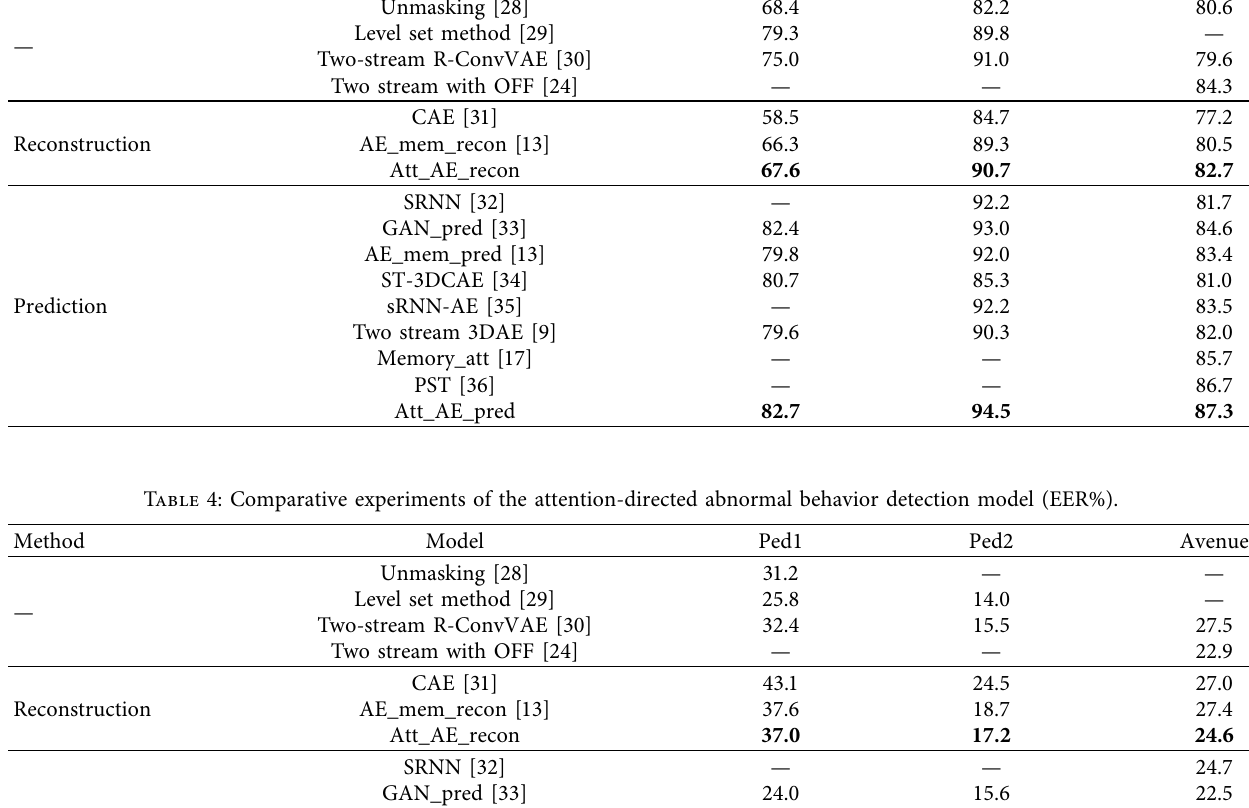
Table 3: Comparative experiments of the attention-directed abnormal behavior detection model (AUC%). Method